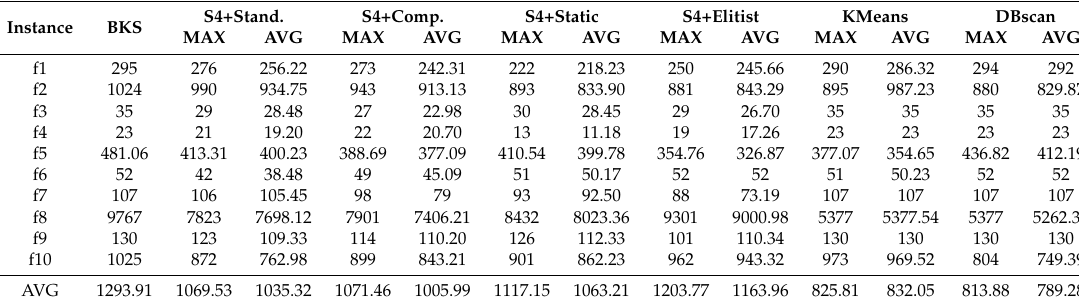
Table A15. CSA/KP—SShape 4—Two-steps vs. KMeans vs.